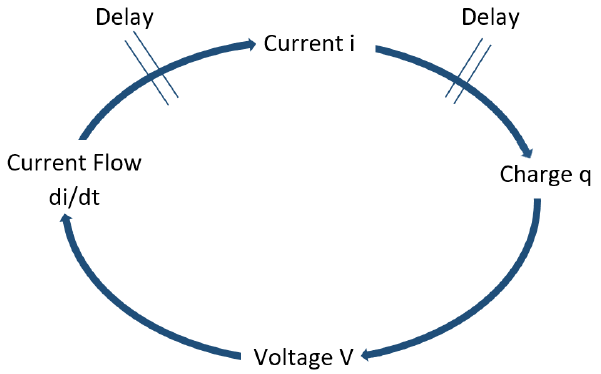
Fig. 21. LC circuit causal loop